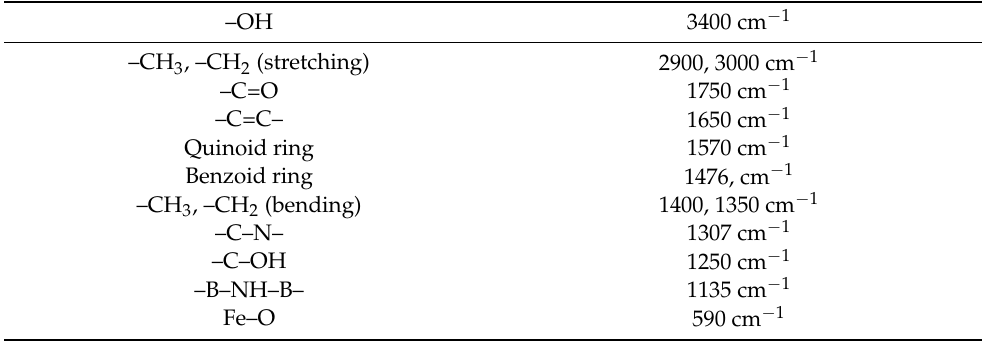
Table 1. Assignments of FTIR